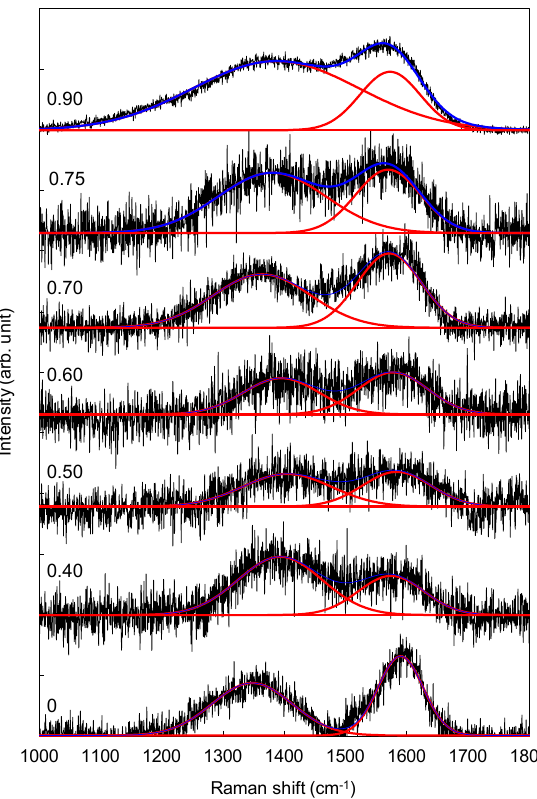
Figure 5. Raman scattering spectra of nanostructured CN x :H films prepared at different N 2 :(N 2 + CH 4 ) flow rate ratio. The deconvolution using Gaussian fittings are also shown.